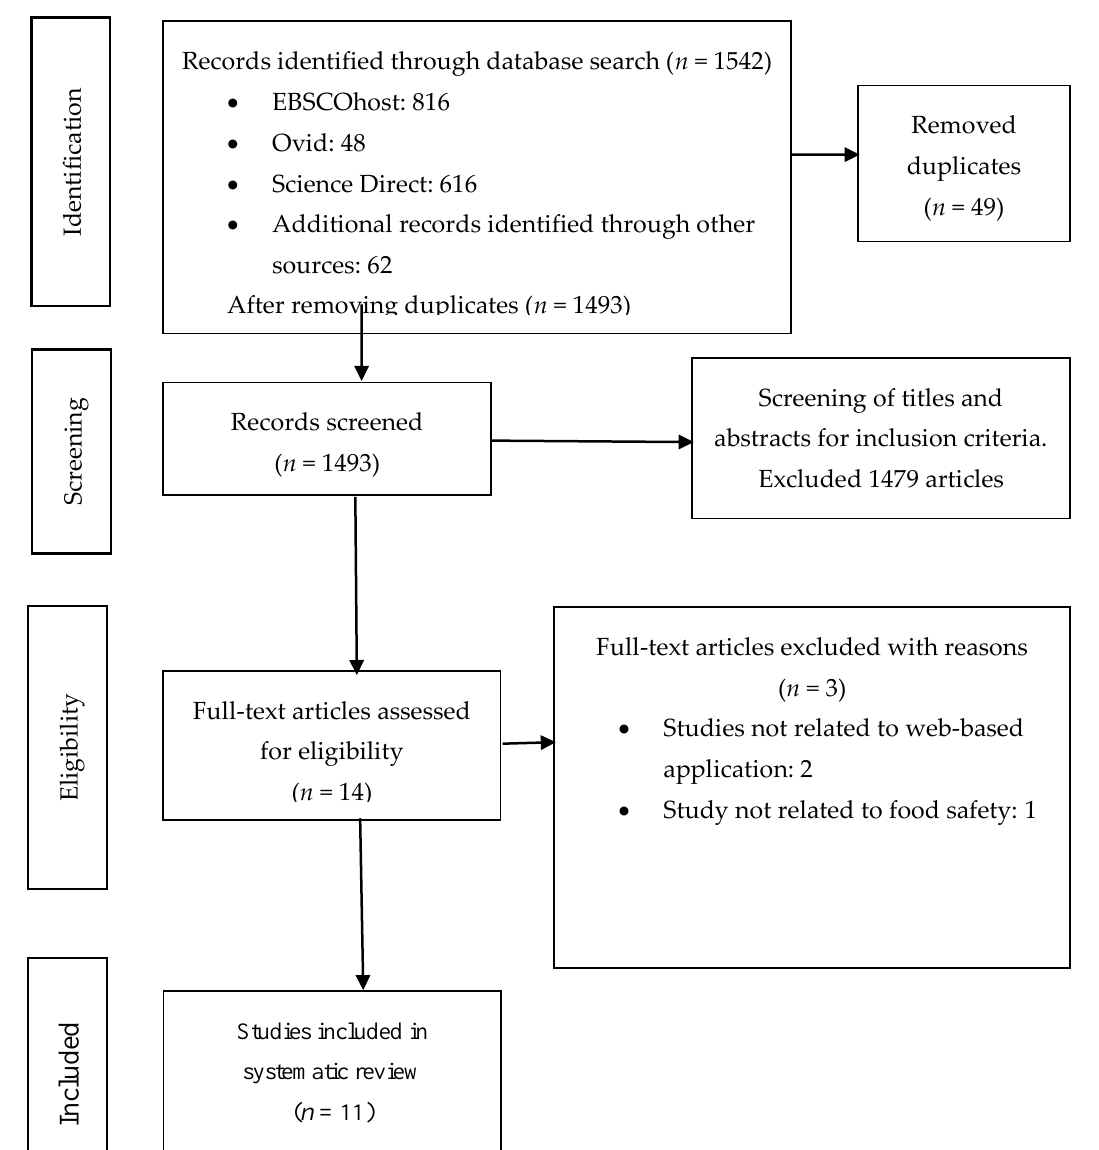
Figure 1. The PRISMA chart of the current review.